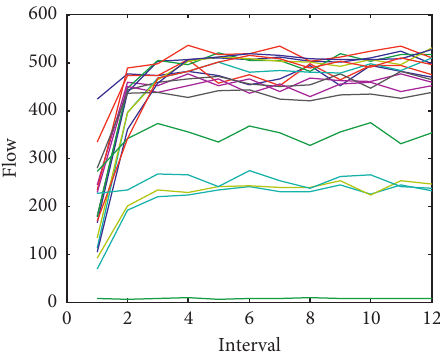
Figure 8: Two-dimensional flow without VSL. Figure 7: Two-dimensional density with VSL.